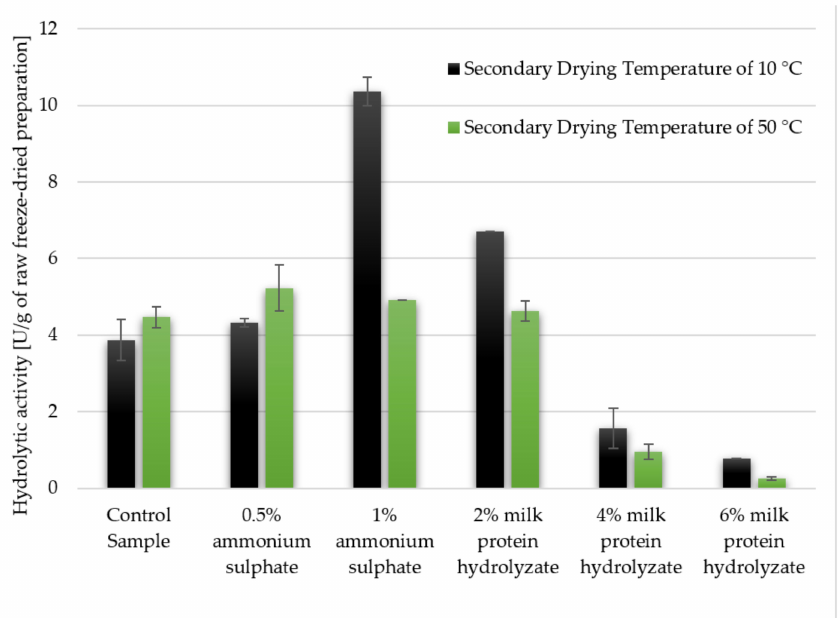
Figure 6. The effect of the applied cryoprotectant and the secondary drying temperature during the freeze-drying process on the hydrolytic activity of the lyophilized enzyme preparation (calculated per 1 g of the preparation, referring only to the lyophilized supernatant, excluding the presence of the cryoprotectant). Experiments were performed in